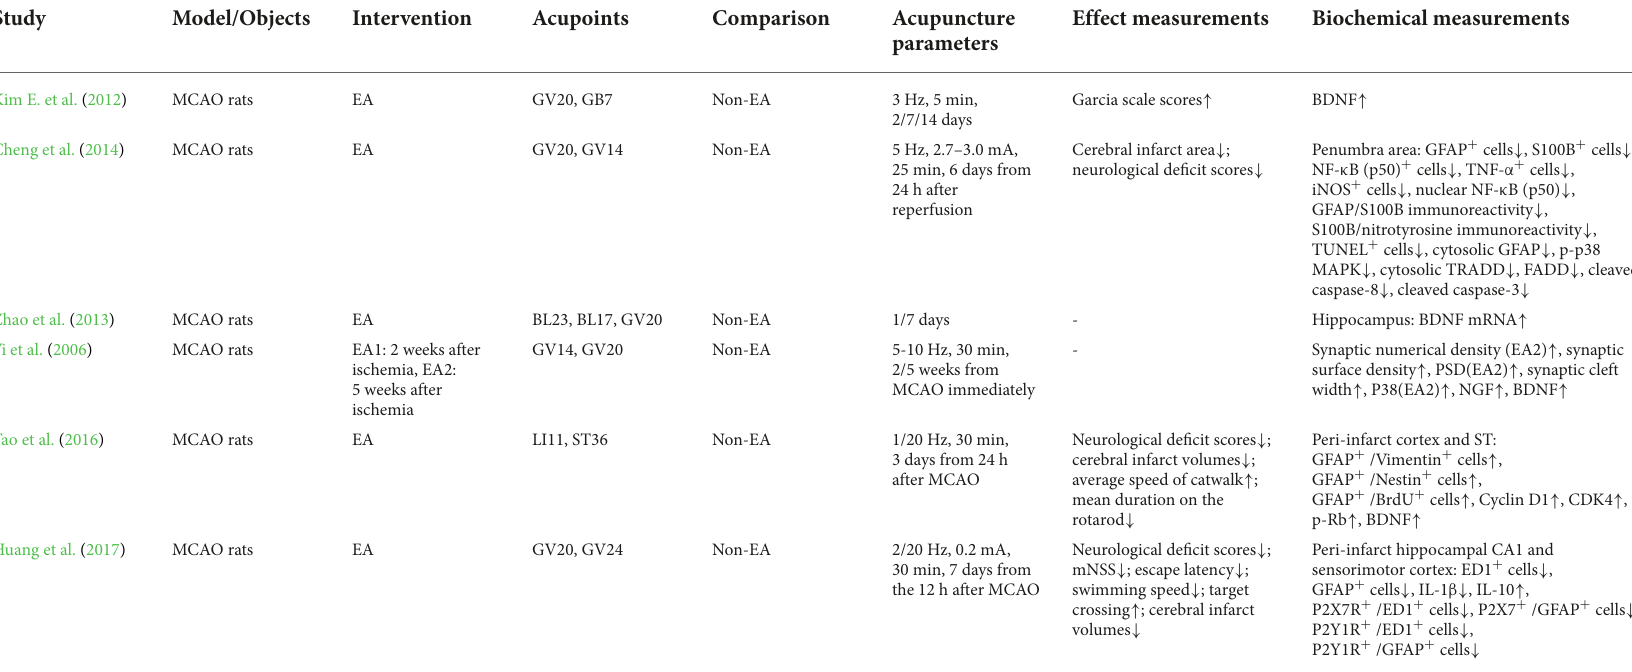
TABLE 2 The mechanisms of glial cells in the regulation of neuroplasticity by acupuncture in the treatment of ischemic